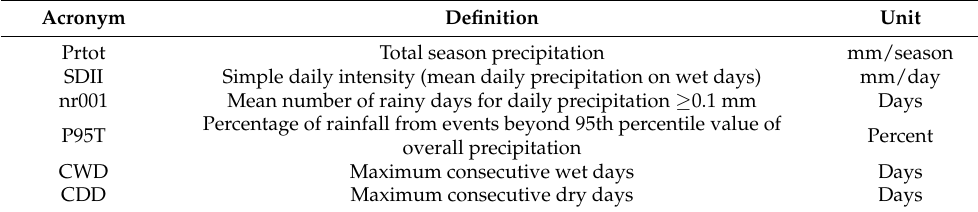
Table 1. Definition of precipitation